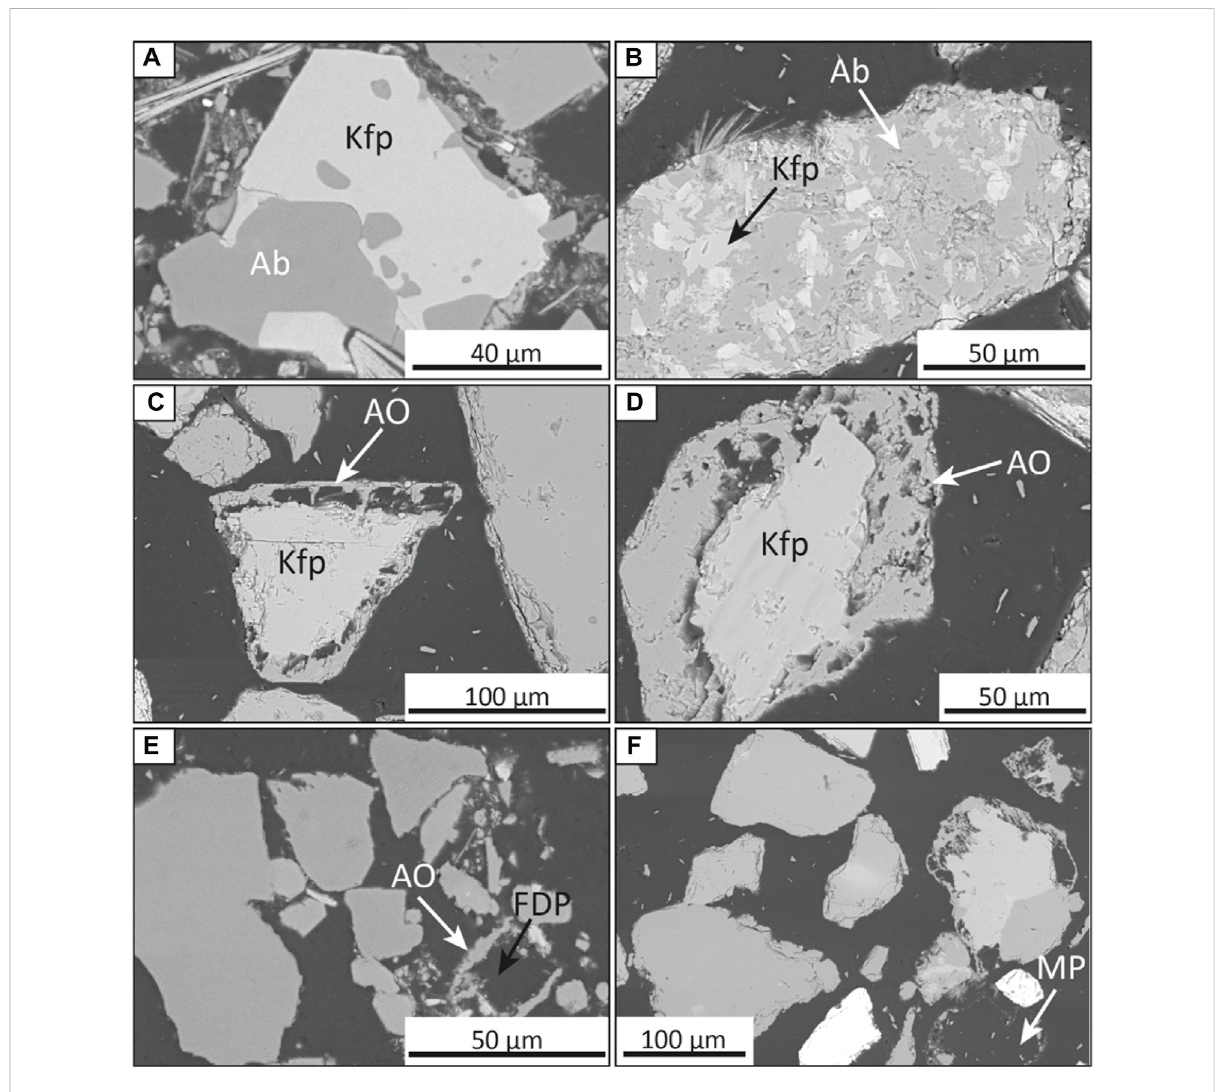
FIGURE 11 BSEimagesshowingexamplesofalbitizationoffeldspar,developmentofalbiteovergrowths,anddissolutionoffeldsparsinthereactedsamples of the Bute Inlet. (A) BSE image showing blocky albitization of K-feldspar (Kfp) (Sample 3). (B) BSE image showing pervasive albitization (Ab) of K-feldspar (Kfp) (Sample 3). (C) BSE imageshowingdevelopment ofthinalbite overgrowth (AO) (Sample3).Notehowtheovergrowth grows intothe dissolved K-feldspar, suggesting that thedissolution predated thedevelopment of theovergrowth. (D) BSE imageshowing thedevelopmentof thick albite overgrowth (AO) on detrital K-feldspar (Sample 3). (E) BSE image showing dissolved feldspar grain being rimmed by albite overgrowth (AO), creating feldspar-dissolution porosity (FDP) (Sample 6). (F) BSE image showing a moldic pore (MP), formed from the complete dissolution of a feldspar grain (Sample 2). (BSE, Backscattered